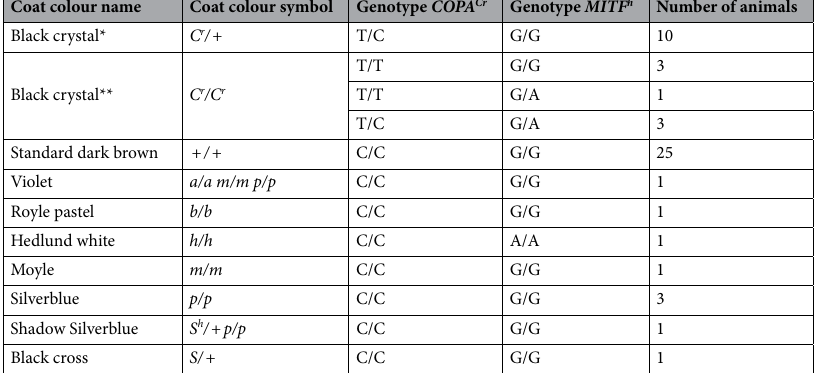
Table 2. Results of COPA Cr and MITF h genotyping in American mink. The p -value is 0.00023 for association of the T allele of COPA Cr with Black crystal fur colour (OR = 218; 95% CI 12.45–3825.13). *Animals with white guard hairs on the spine and head. **Completely white animals, with no hearing